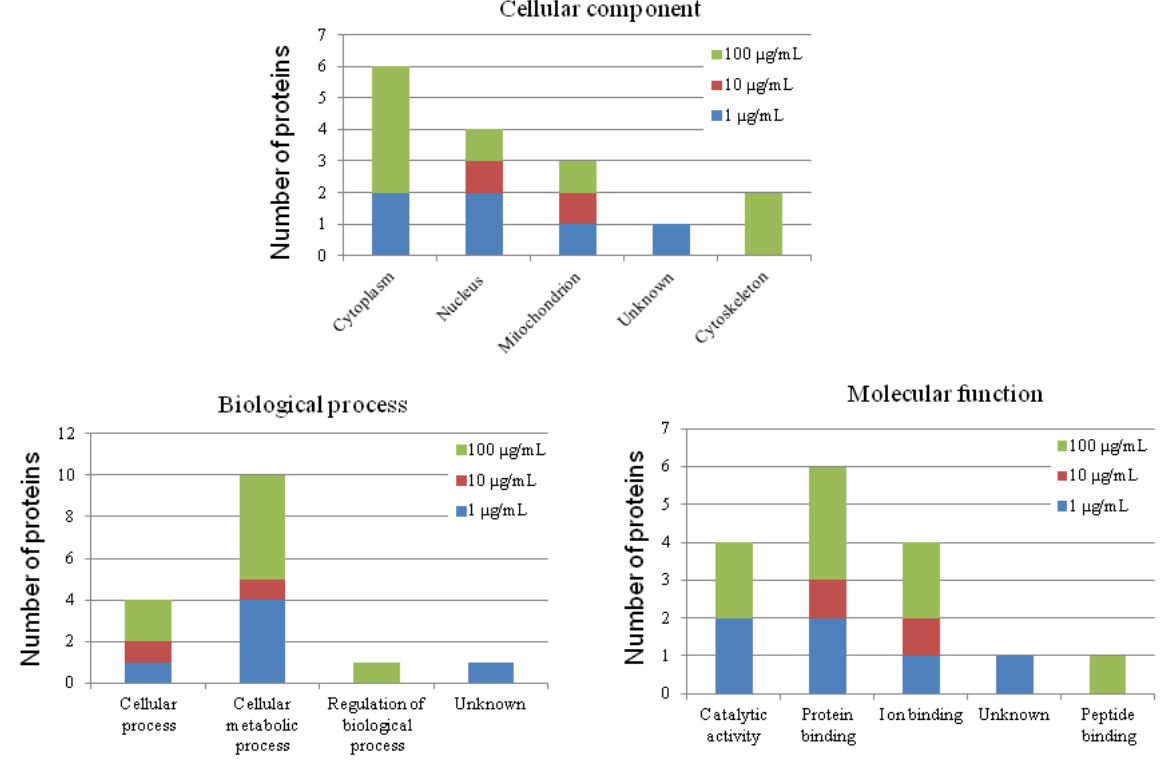
Figure 5. Gene ontology (GO) annotation of differentially expressed proteins in CNT-treated chicken heterophils. The original GO annotations were downloaded from the NCBI Entrez Gene database. The percentages are the total hits, divided by the number of annotated proteins for the